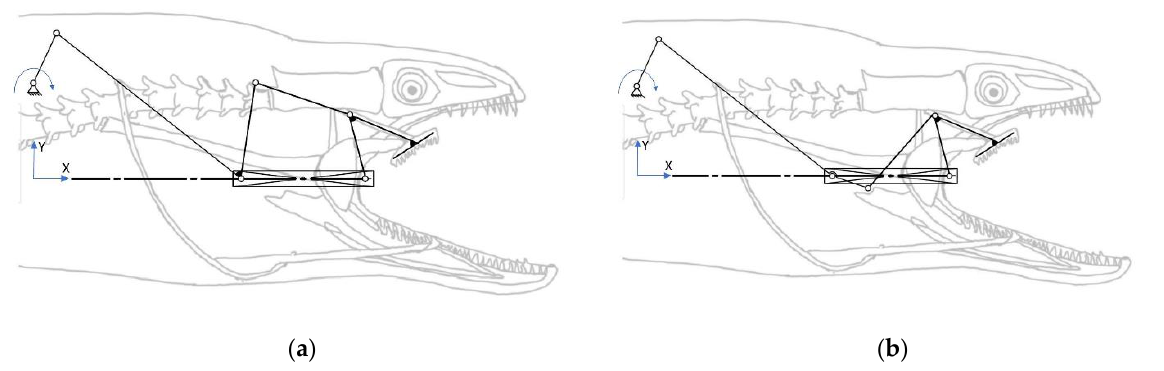
Figure 5. Kinematic chain representation of the pharyngeal jaw: slider – crank mechanism with ( a ) a four-bar mechanism; ( b ) an anti-parallel four-bar mechanism.